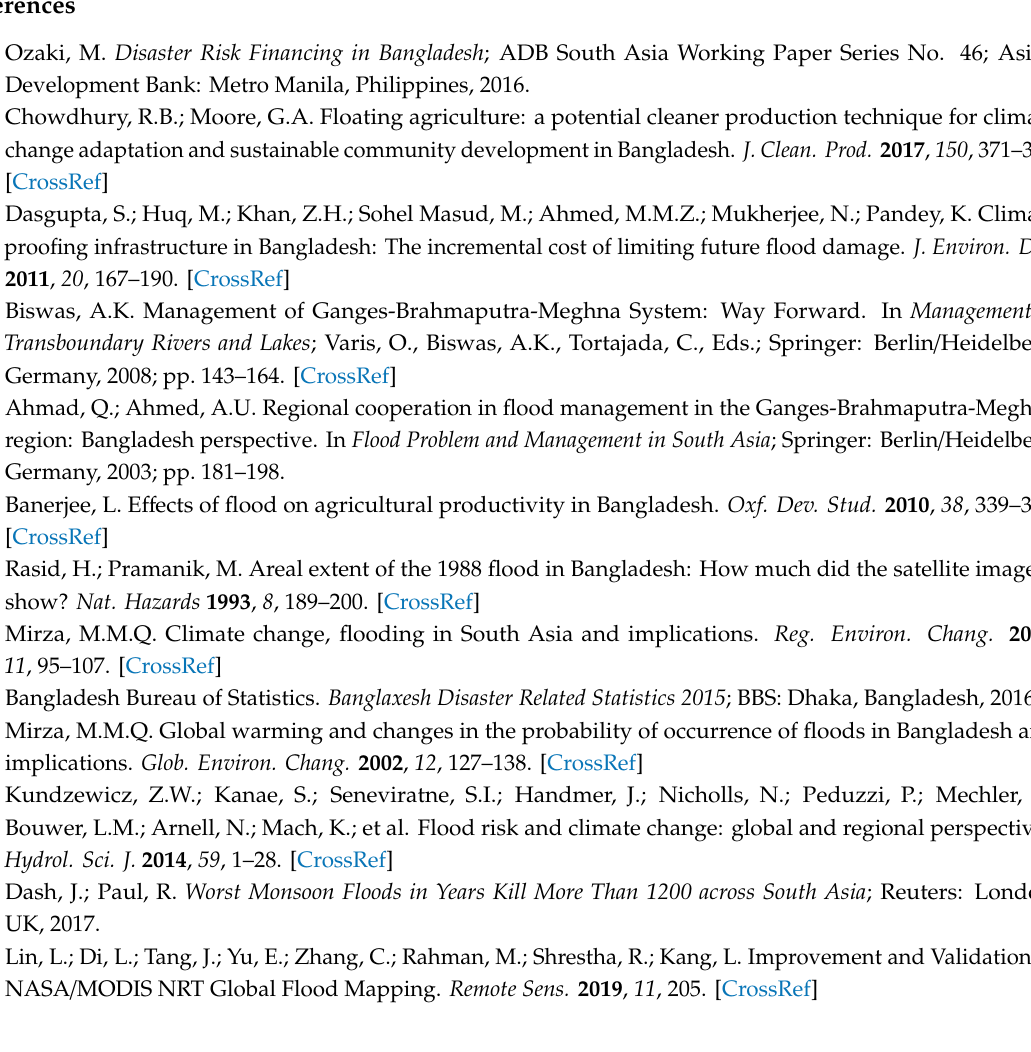
Figure S1. Box plots of Sentinel-1 VH and VV backscatter for flood and non-flood samples, Table S1. List of Sentinel-1 images used for the flood inundation mapping, Table S2. Landsat 8 operational land imager (OLI) spectral bandwidth spatial resolution, Table S3. Land cover classification system (LCCS) along with adopted code, Table S4. Omission and commission (%) errors between Landsat (22 August 2017) and Sentinel images (29 August